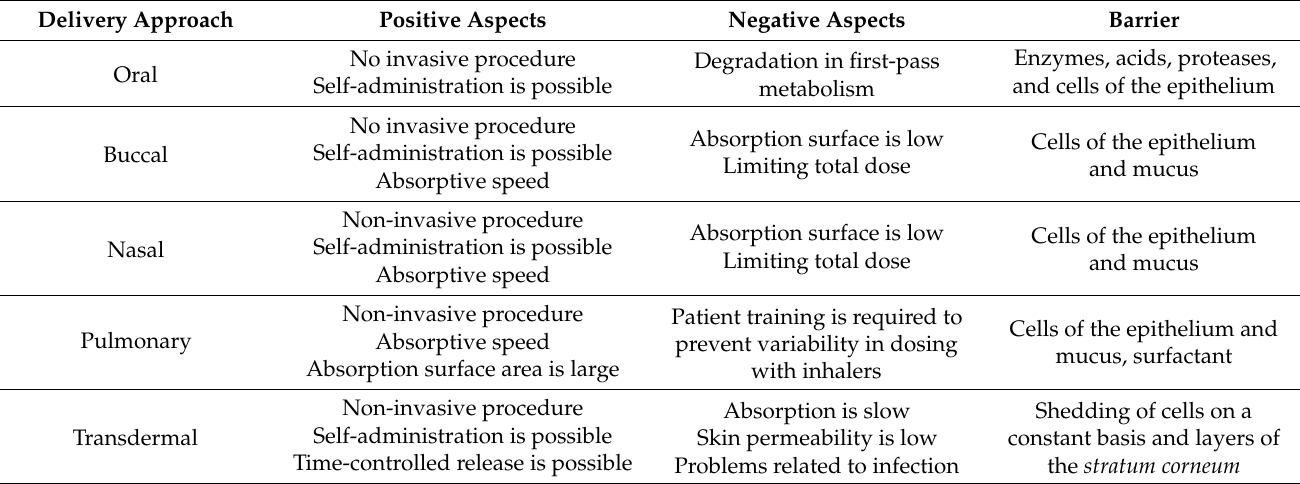
Figure 4. Various platforms for insulin loading and delivery have been explored in the literature, including nanospheres, nanocapsules, dendrimers, solid lipid nanoparticles, transfersomes, and nanogels [44]. Table 1. A brief summary of the various administration routes.